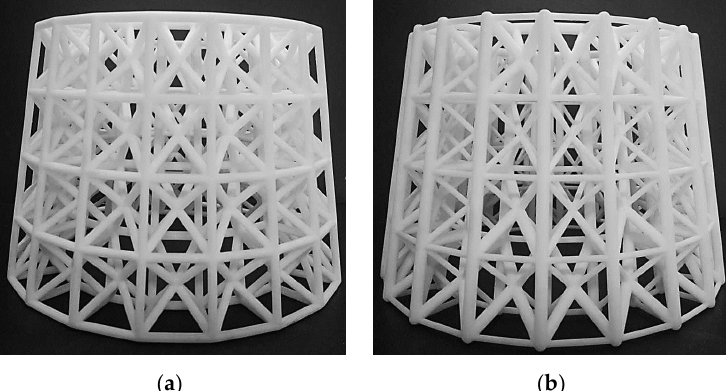
Figure 23. 3D printed samples of: ( a ) initial lattice hollow round platform; and ( b ) optimized lattice hollow round platform.